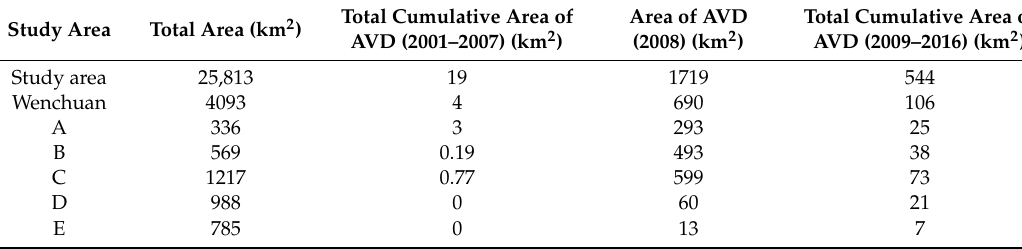
Table 1. Area a ff ected by vegetation damage (AVD) of the study